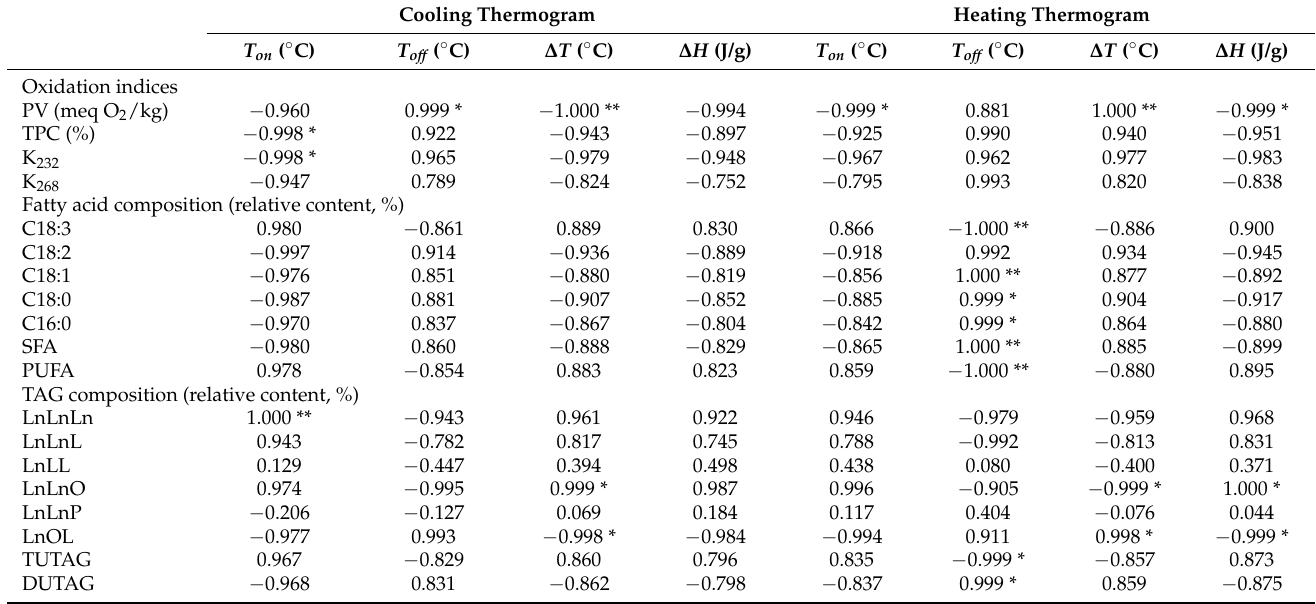
Table 4. Pearson correlation coefficients between main chemical indices and thermal properties of flaxseed